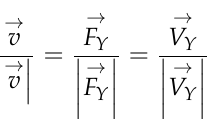
Figure 5. ( a , b ) Angle of repose experiment of soil. Table 1. Soil parameters for simulation. Parameters